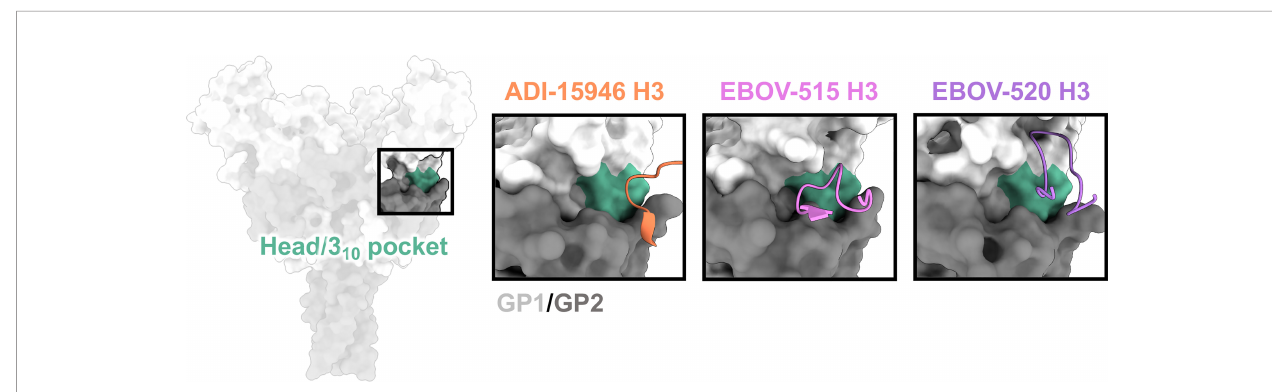
FIGURE 4 | The base and 3 10 pocket domains. The base domain lies below the glycan cap and above the very bottom of GP, and contains the cryptic 3 10 pocket (green), which is occupied by the bottom of the b 17- b 18 loop in unliganded/uncleaved GP. Broadly neutralizing antibodies gain access to the 3 10 pocket by mimicking and displacing the b 17- b 18 loop, typically through extended CDRH3 loops. ADI-15946 (orange, PDBID: 6MAM) has a smaller 3 10 footprint and thus less broad neutralizing activity. EBOV-520 (purple, PDBID: 6PCI) also binds to regions outside of the 3 10 pocket and thus slightly lower activity toward more divergent ebolavirus species like SUDV. EBOV-515 (pink, PDBID: 7M8L) has the broadest neutralizing activity due to a targeted footprint toward the most conserved portions of the